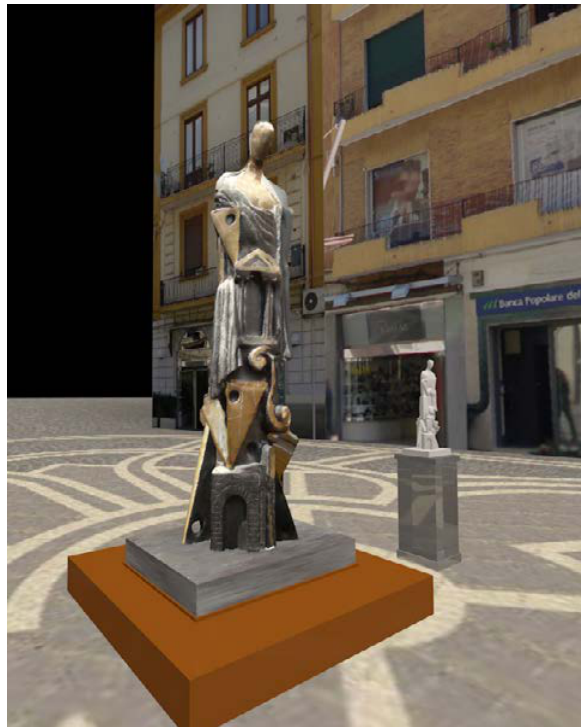
Figure 23. The model of The great Metaphysicist and of the miniature in the new